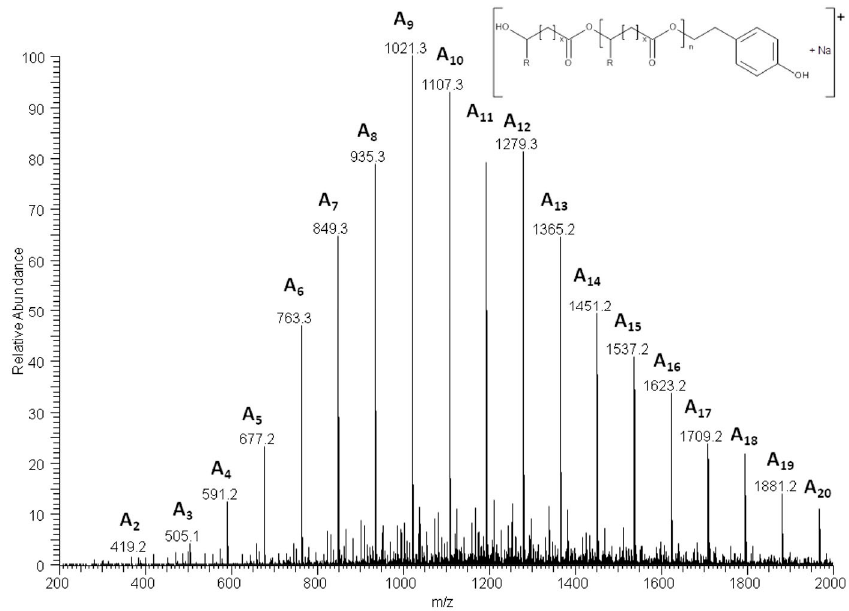
Figure 2. ESI-MS spectrum in positive-ion mode of the tyrosol-oligo(3HB- co -4HB) conjugates obtained by transesterification reaction between P(3HB- co -4HB) and tyrosol (for 3HB units R = CH 3 , x = 1, for 4HB units R = H and x = 2).